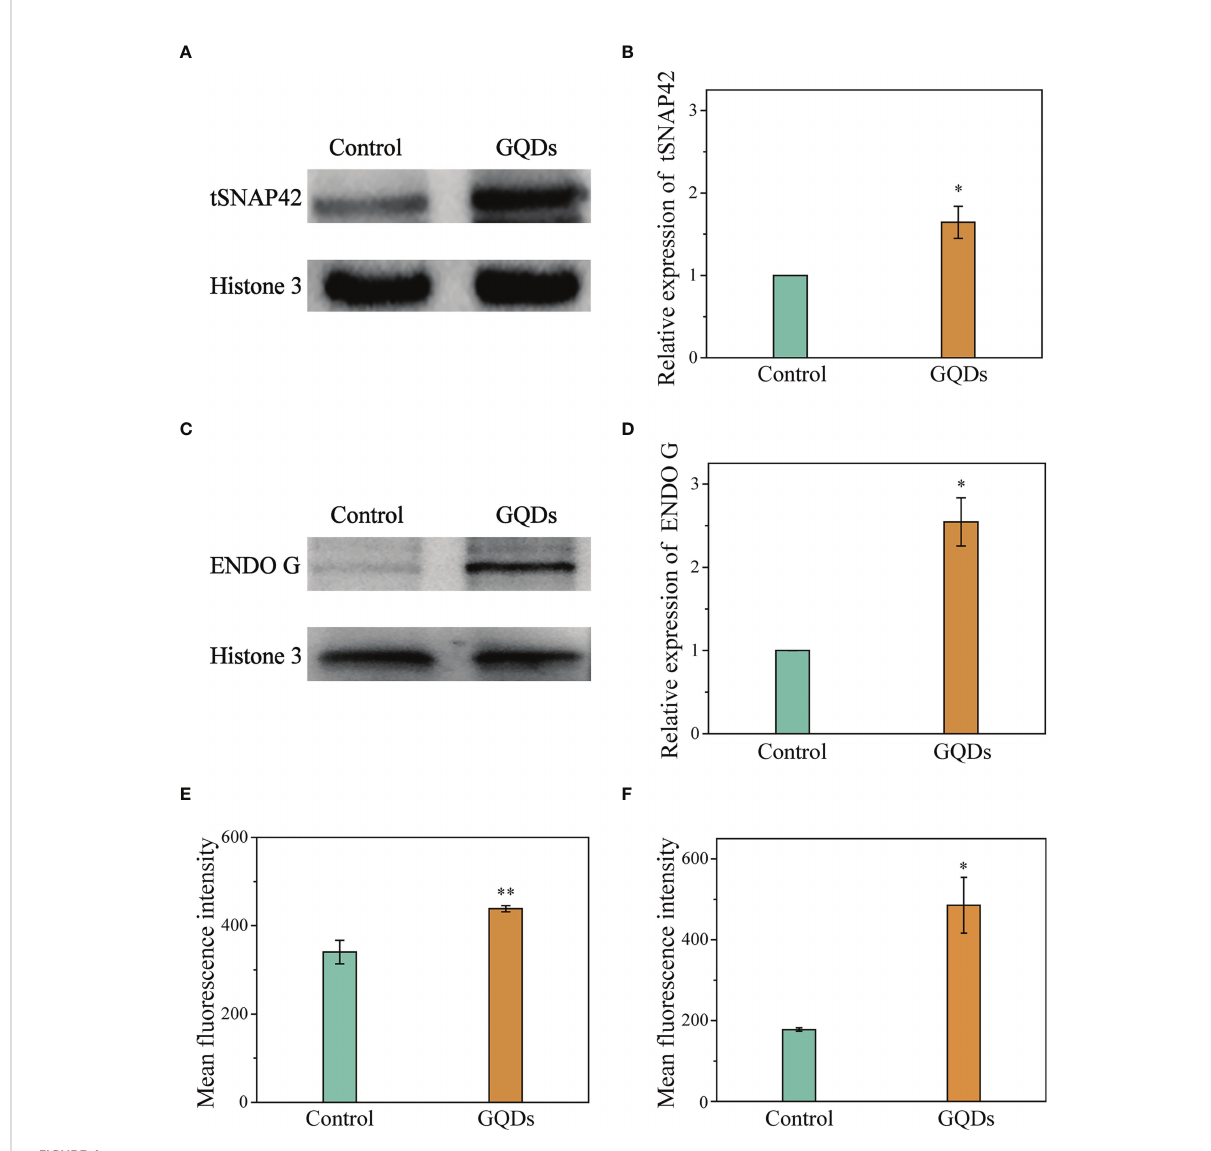
FIGURE 4 Elevation of the apoptosis-associated proteins of Trypanosoma brucei after exposure to graphene quantum dots (GQDs). (A) Increased intracellular accumulation of tSNAP42 in T. brucei after treatment with GQDs as revealed by Western blotting analysis. Histone 3 served as the control. (B) Densitometric analysis of the gray images in (A) using ImageJ software (v1.8.0). (C) Increased quantity of endonuclease G (Endo G) in T. brucei revealed by Western blotting analysis. Histone 3 served as the control. (D) Densitometric analysis of the gray images in (C) using ImageJ software (v1.8.0). (E, F) Increased intracellular accumulation of tSNAP42 (E) and Endo G (F) in T. brucei after treatment with GQDs as determined by fl ow cytometry (Supplementary Figure S11). T. brucei parasites that were not exposed to GQDs served as controls. Data shown are the mean ± SD ( n ≥ 3). Student ’ s t -test was used to obtain p -values. * p < 0.05, ** p < 0.01 (compared to the